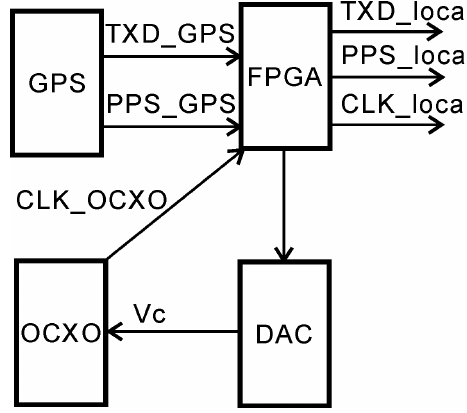
Figure 4. Block diagram of the clock